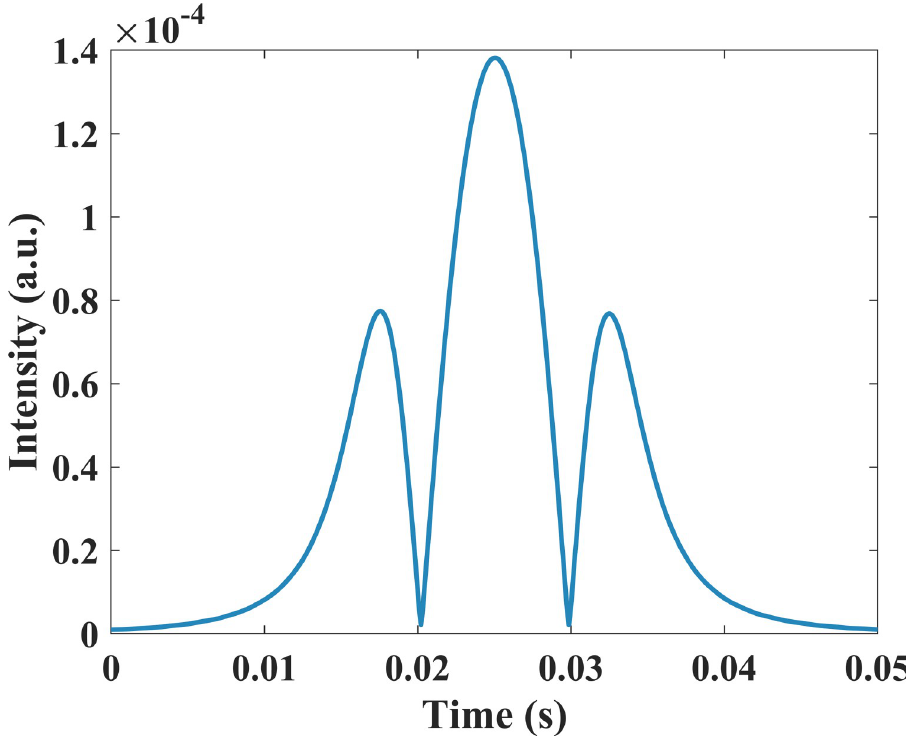
Fig 3. The second harmonic demodulated by the Hilbert transform-based method.